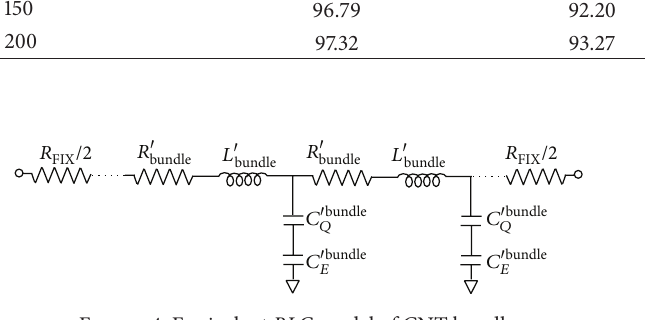
Figure 4: Equivalent RLC model of CNT bundle.